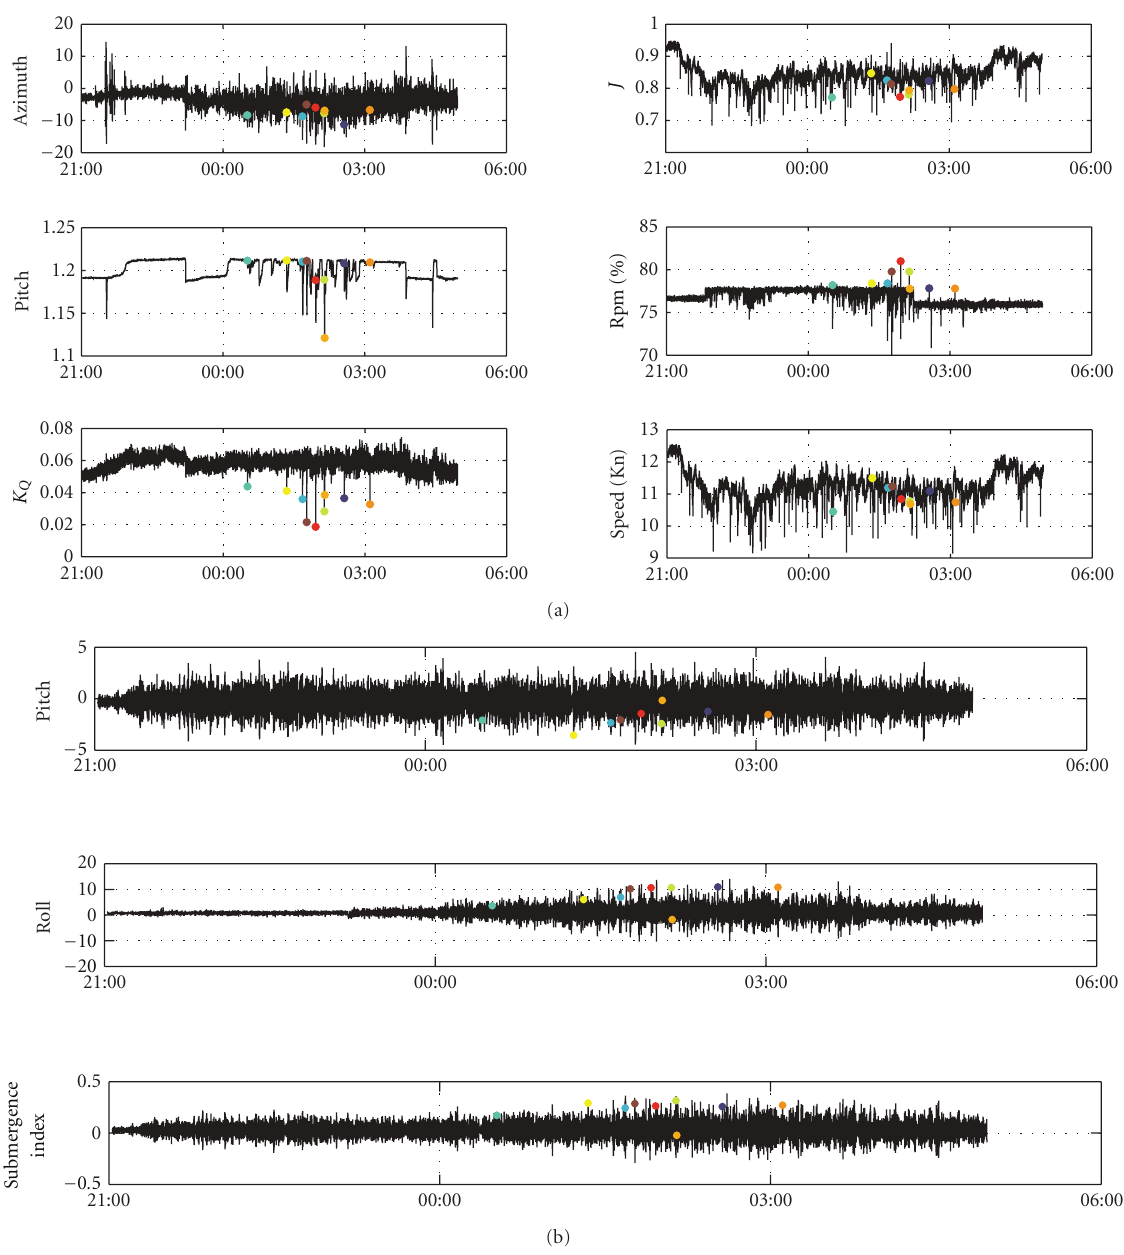
Figure 7: Time series showing HEMOS data (a) and ship environmental data (b) with the marked